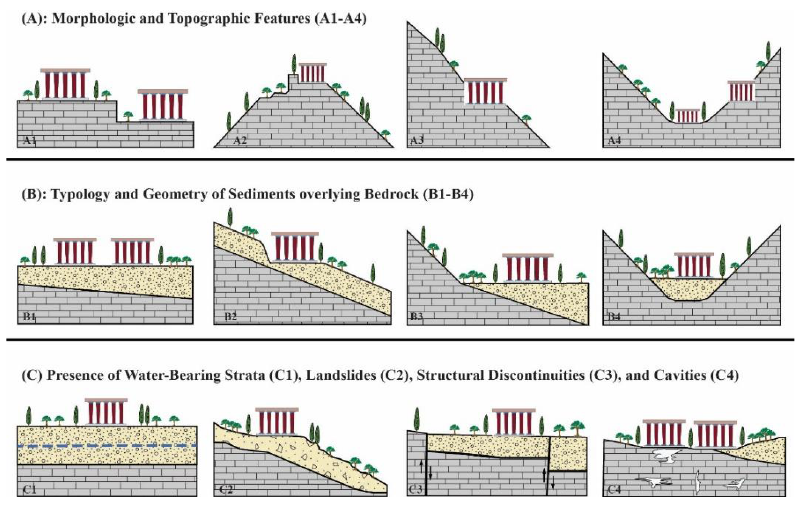
Figure 2. Sketch illustrating the conceptualized main geomorphologic categories ( A – C ) with the corresponding possible scenarios (sub-categories ( A1 – C4 ), respectively) for local site response. (Adapted with permission from Ref. [25]. Copyright 2013, Panzera et al.). The black arrows in C3 indicate a fault and its direction of